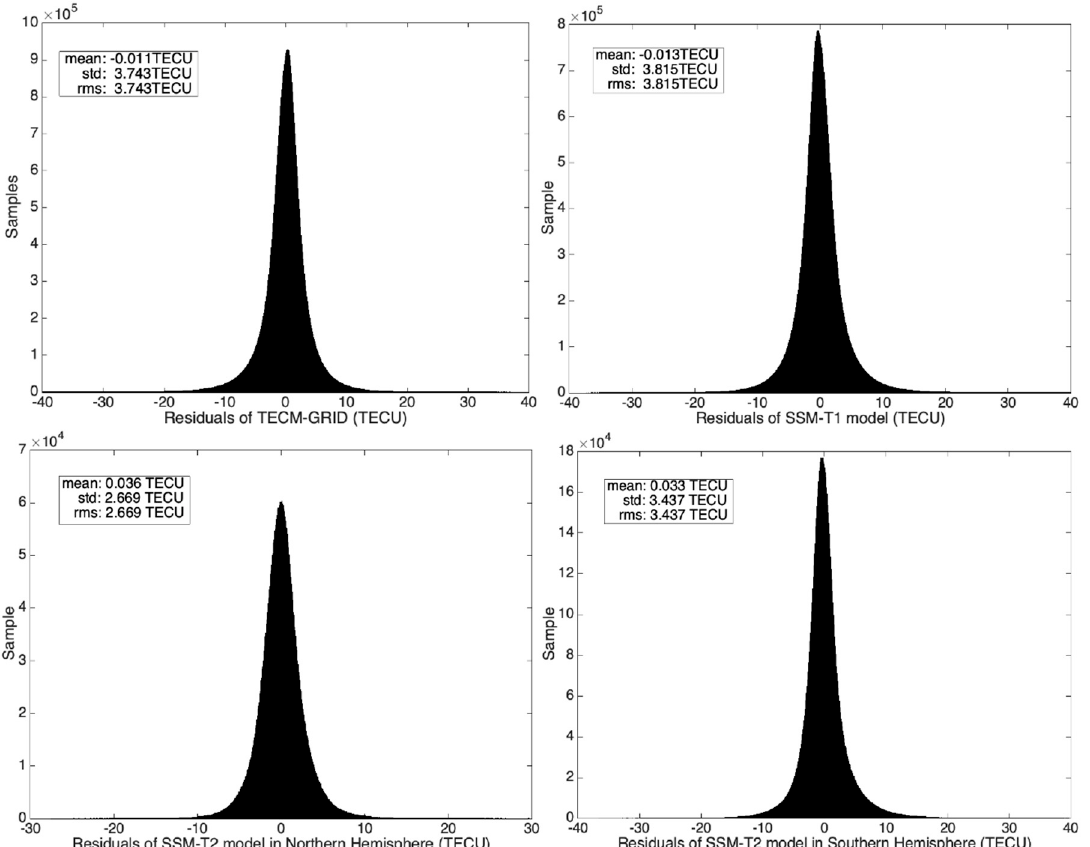
Figure 2. Model Residual Distribution Histogram of TECM-GRID and sub-models (SSM-T1 and SSM-T2).